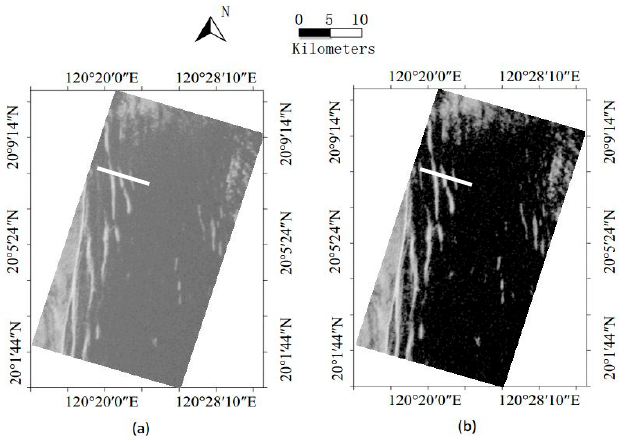
Figure 5. Subimages of Frame 1 in Figure 3, ( a ) conventional SAR image; ( b ) estimated normalized radar cross-section (NRCS) image.